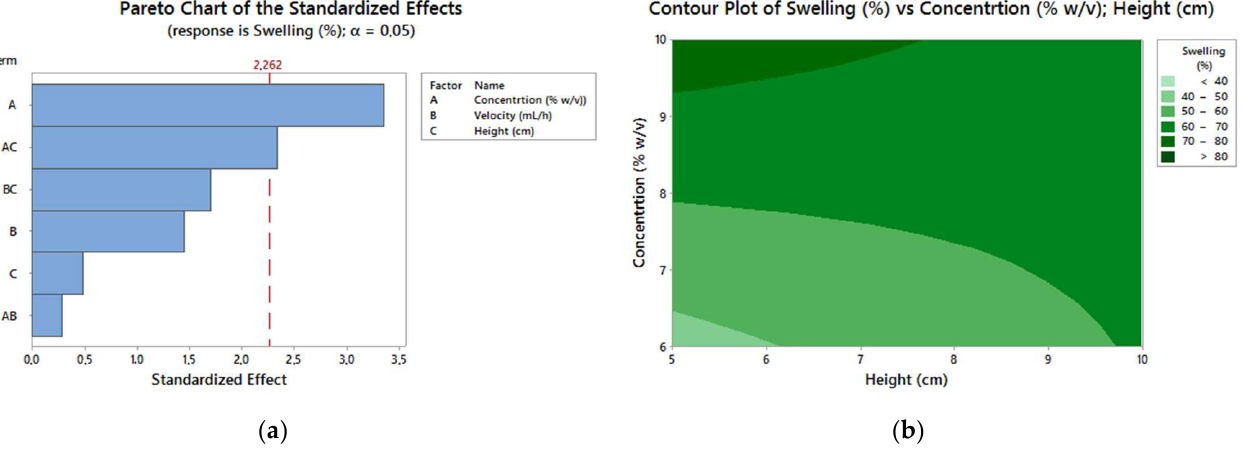
Figure 7. ( a ) Pareto chart; ( b ) contour chart of swelling.